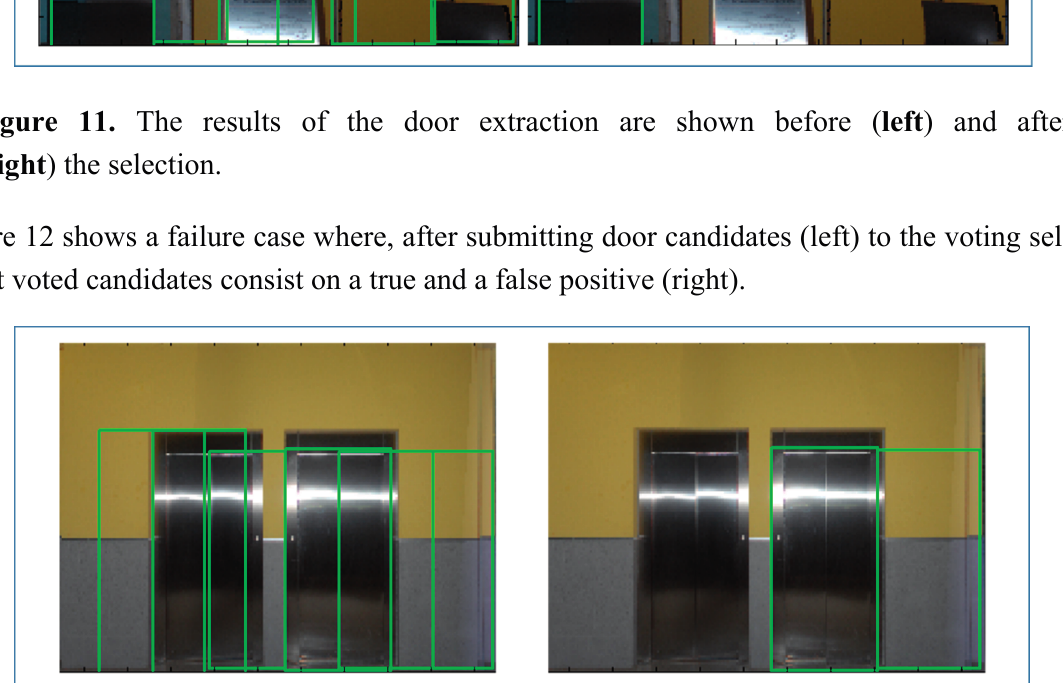
Figure 12. The results of the door extraction in a failure